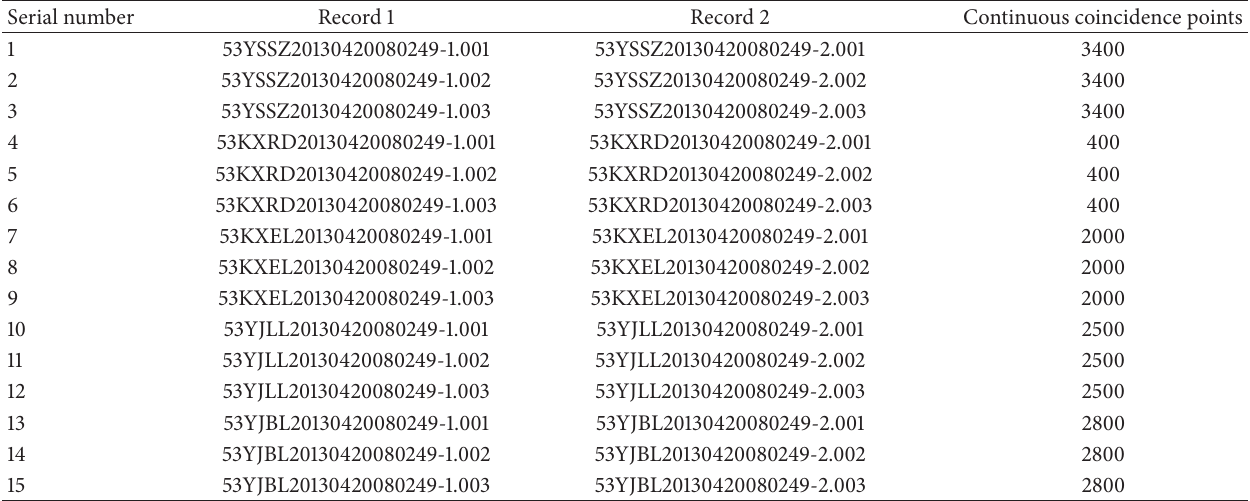
Table 5: Cases for strong motion record